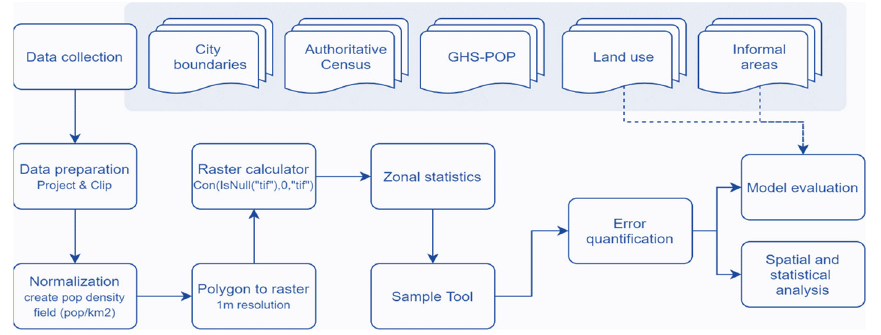
Figure 1. Methodology flowchart.